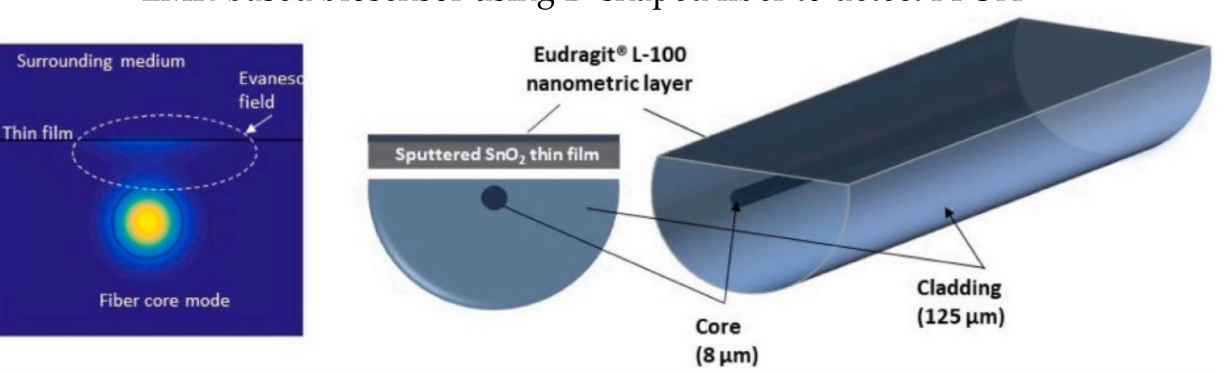
Figure 14. Schematic diagram of D-shape fiber coated with a thin-film layer tin dioxide (SnO 2 ), which was deposited by a DC sputter machine. Reprinted with permission from Ref.